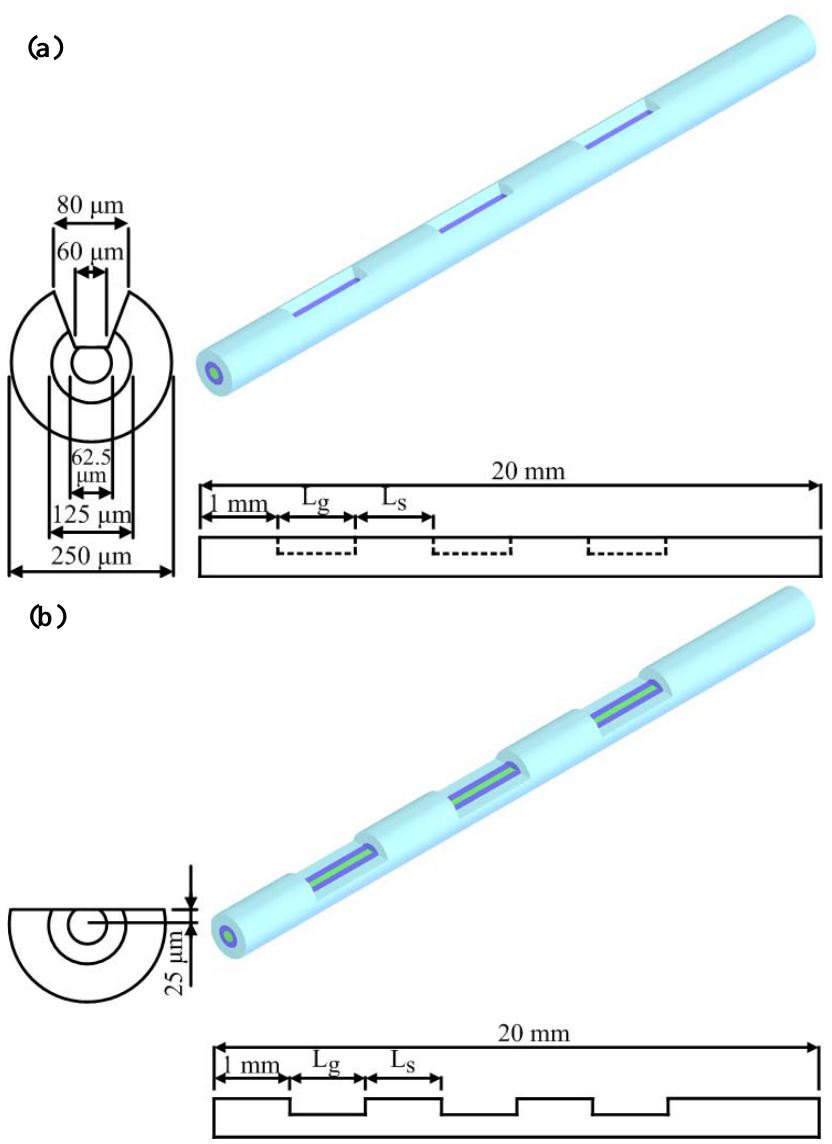
Figure 2. Dimensions and design of the grooved fibers. (a) U-type fiber. (b) D-type